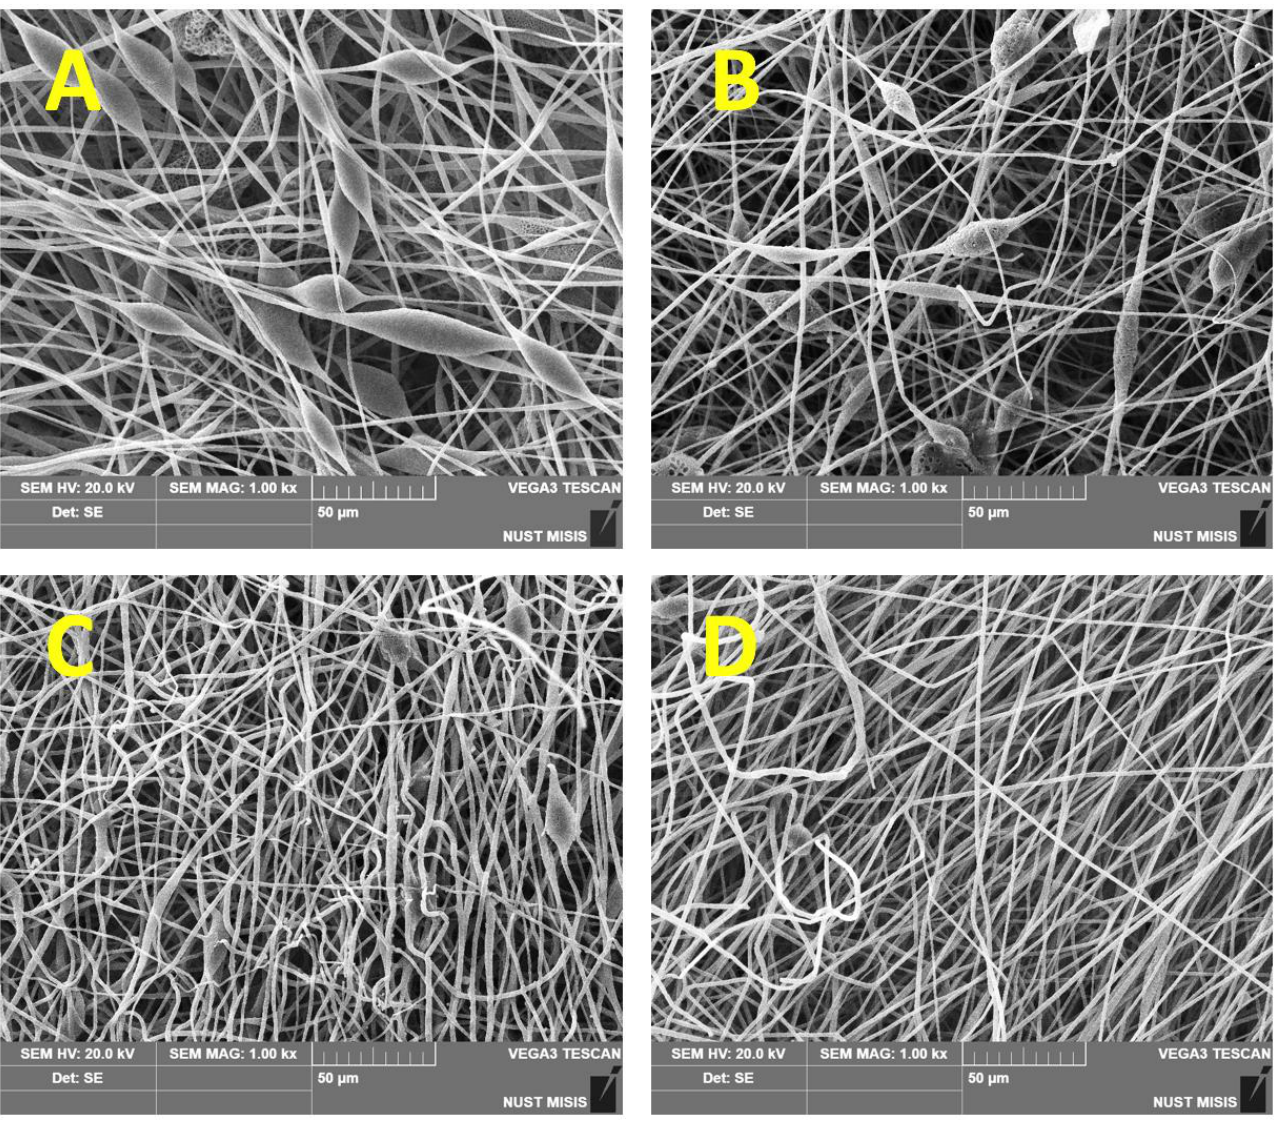
Figure 3. SEM micrographs of PHB and Hmi /PHB nonwoven materials with different content of Hmi : ( A ) neat PHB, ( B ) Hmi /PHB with 1 wt.% of Hmi , ( C ) Hmi /PHB with 3 wt.%, ( D ) Hmi /PHB with 5 wt.% of Hmi .